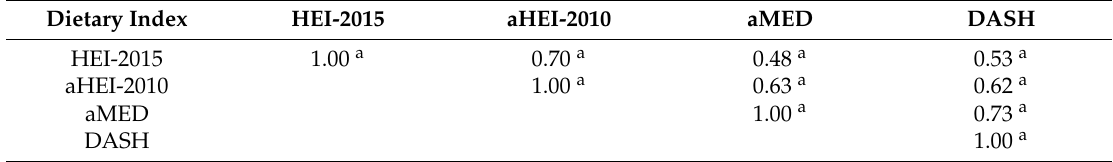
Table 2. Correlation between elevated dietary index scores for all women ( n = 111).